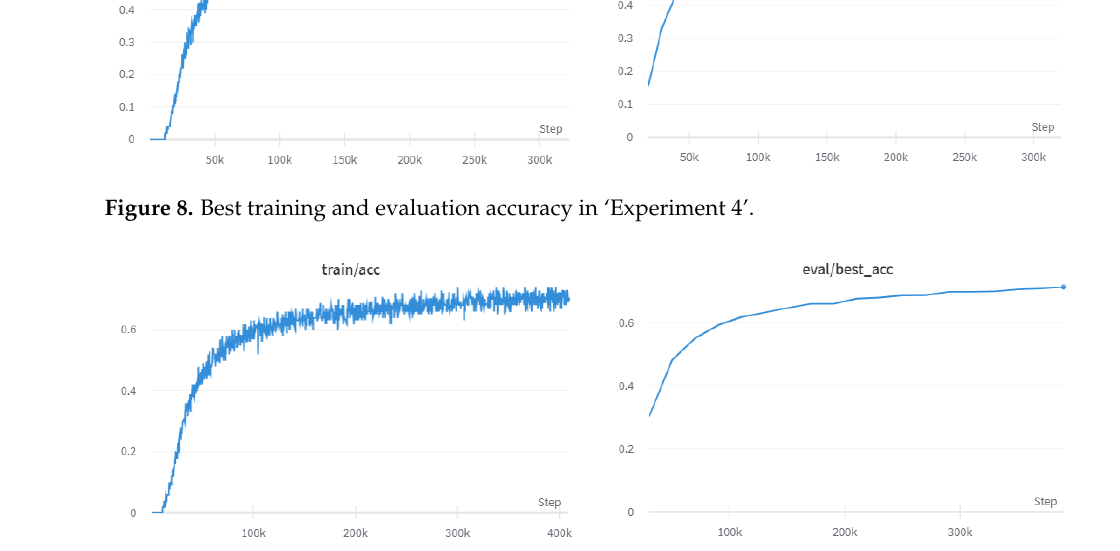
Figure 9. Best training and evaluation accuracy in ‘Experiment 5’.